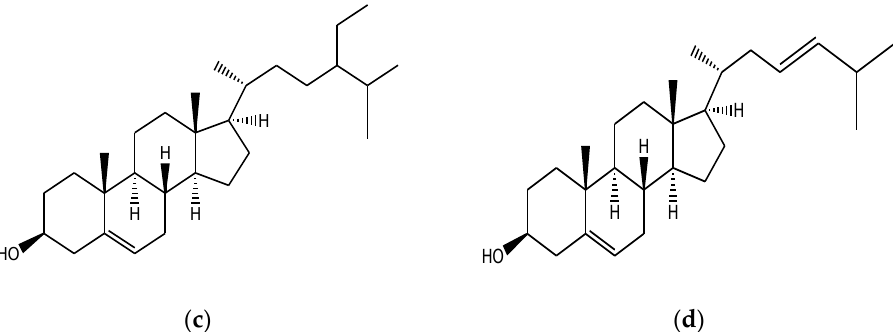
Figure 1. Chemical structures of the compounds 1 - 4 . ( a ), (-) kaur- 16α -hydroxy-19-oic acid; ( b ), (-) kaur-16-en-19-oic acid; ( c ) , β -sitosterol; ( d ), cholesta-5,23-dien-3-ol.